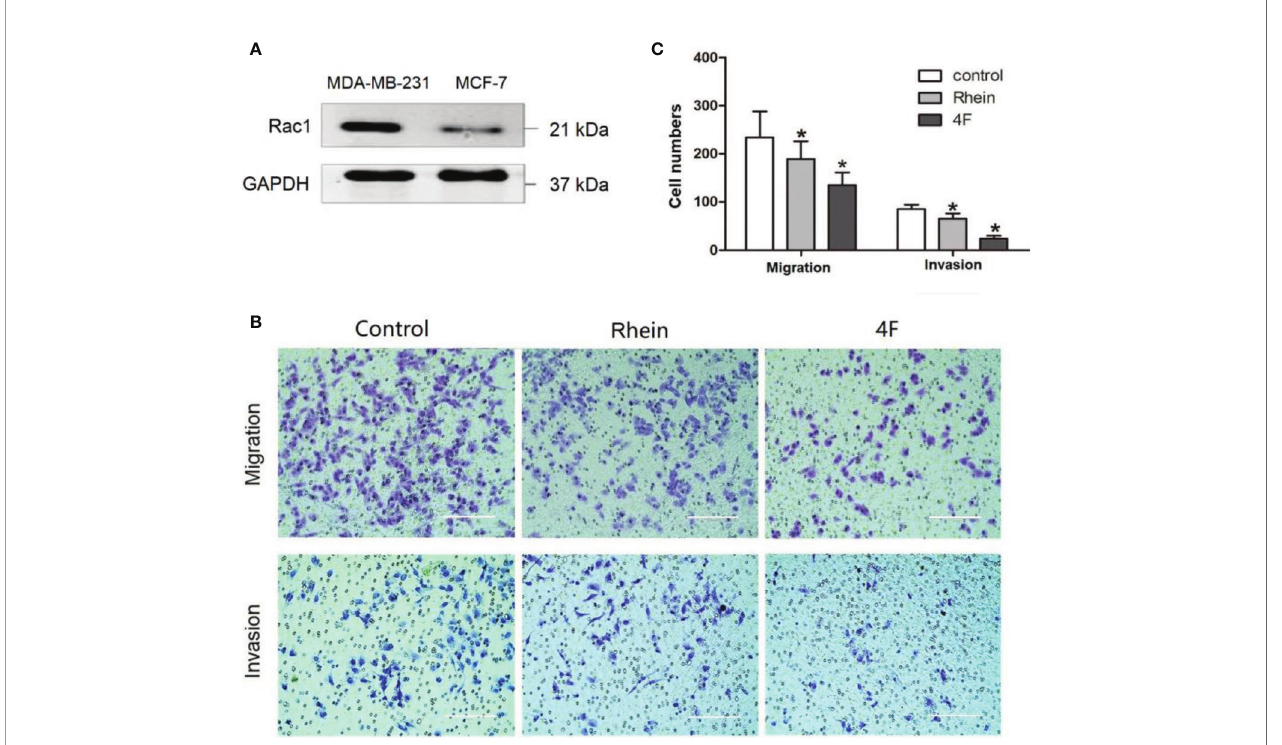
FIGURE 3 | Transwell assay to test MDA-MB-231 cell migration and invasion ability. The control group correspond to cells growing without any drug. (A) Rac1 protein expression in MDA-MB-231 and MCF-7 cells. (B) Transwell assay of MDA-MB-231 cells (scale bar: 200 m m). (C) Numbers migrated and invaded MDA-MB- 231 cells. Data are shown as means ± SD (n = 5). One-way analysis of variance (ANOVA) was used for statistical analysis. * P < 0.05, comparison of Rhein group or derivative 4F group and control group on MDA-MB-231